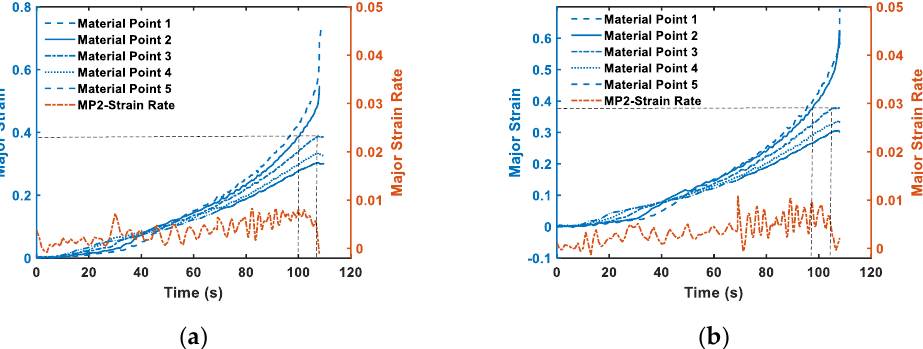
Figure 10. Major strain and strain rate evolution for two independent tests on a 70 mm wide specimen: ( a ) the first test; ( b ) the second test.